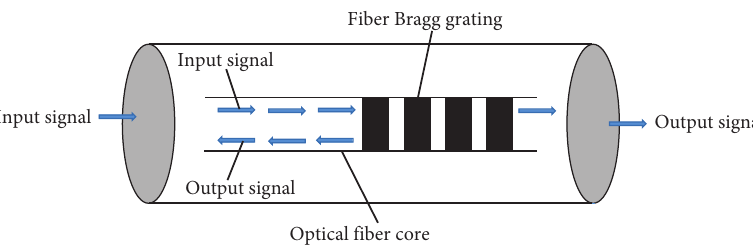
Figure 8: Principle of fiber grating technology.